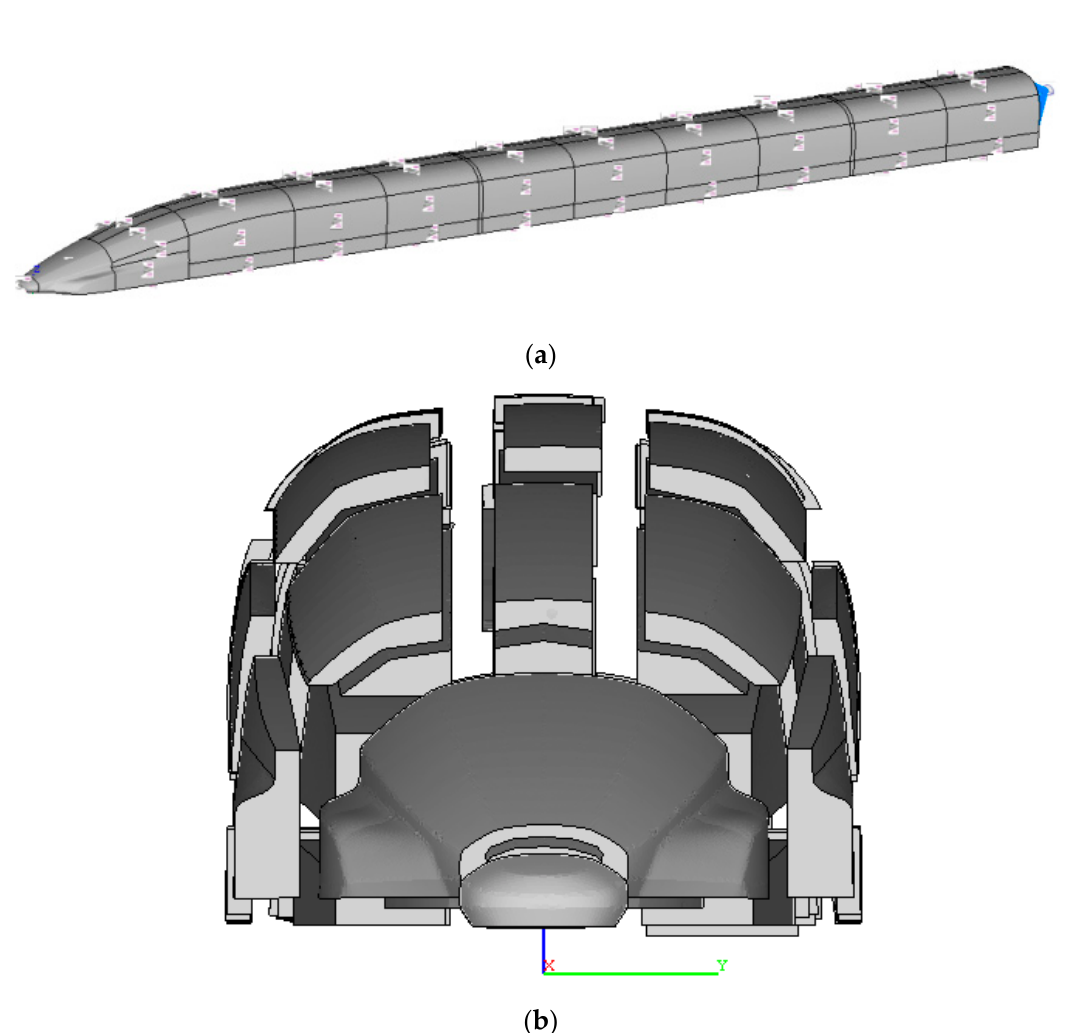
Figure 7. Statistical energy analysis model of the high-speed maglev train: ( a ) Side view of the subsystem division, ( b ) front view of the subsystem division.